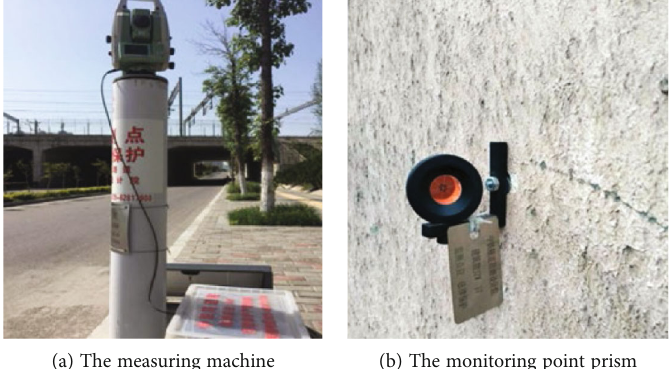
Figure 12: The settlement monitoring equipment.